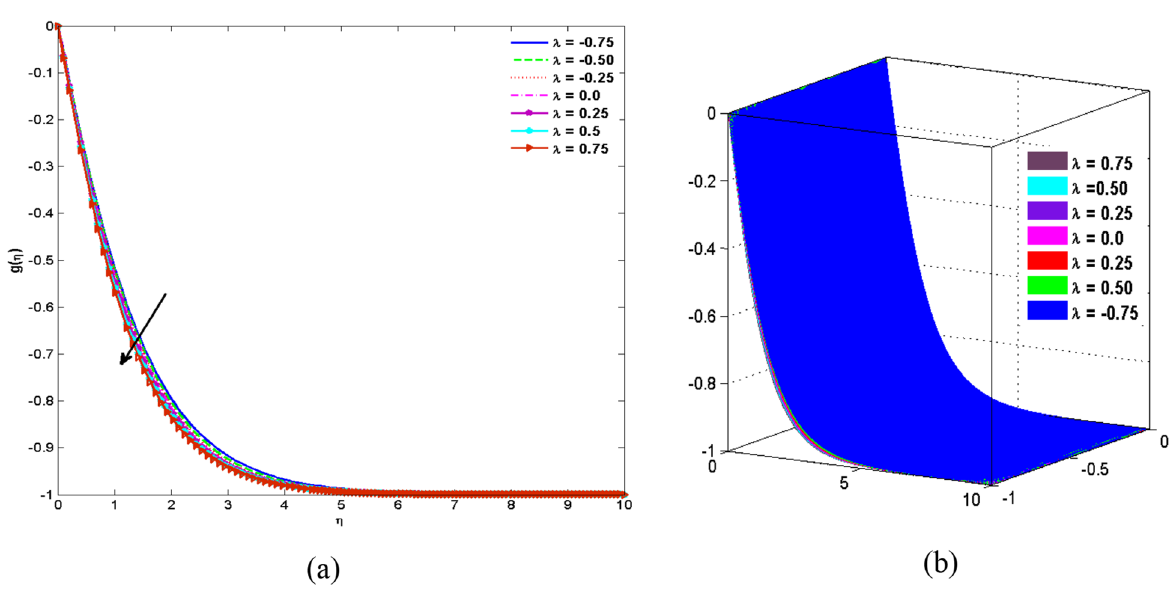
Figure 4. Variations of (cid:31) to g (η)